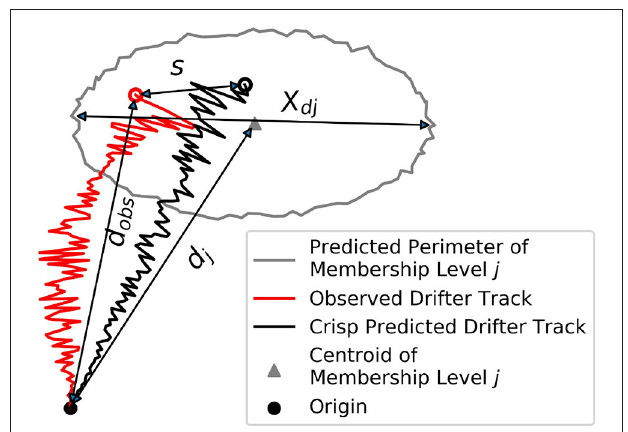
FIGURE 3 | Illustration of instantaneous fuzzy skill score for trajectory evaluation. For clarity only a single membership level is